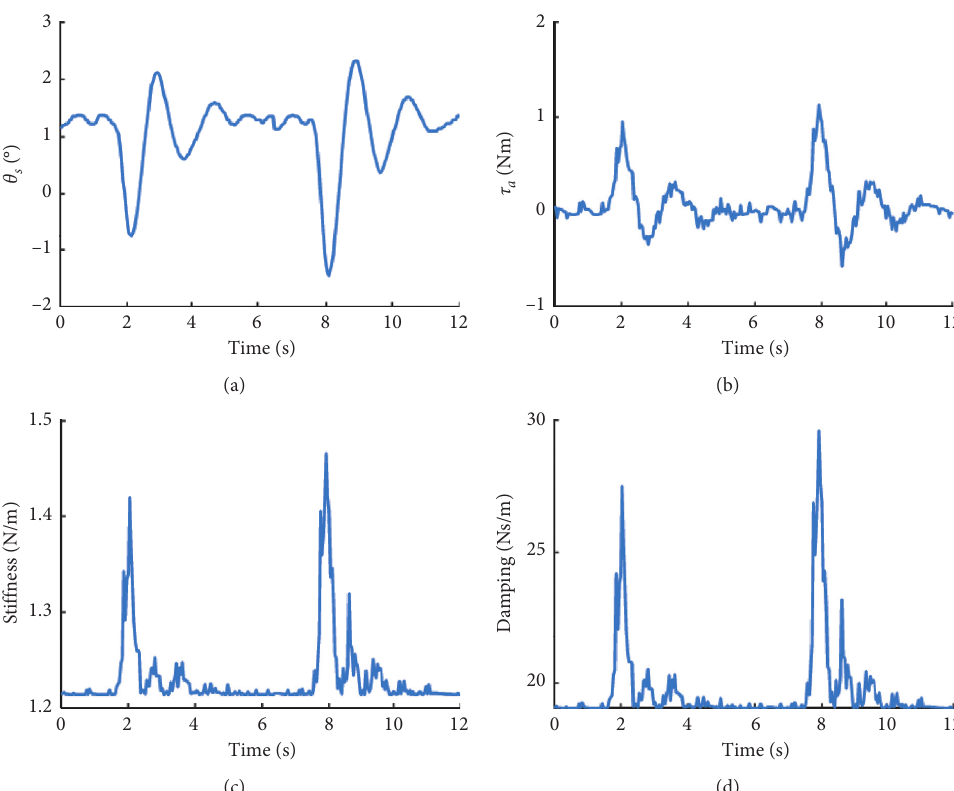
Figure 10: The experimentation results of the bipedal robotic standing balance control. (a) Tilt angle. (b) Ankle torque. (c) Ankle stiffness. (d) Ankle